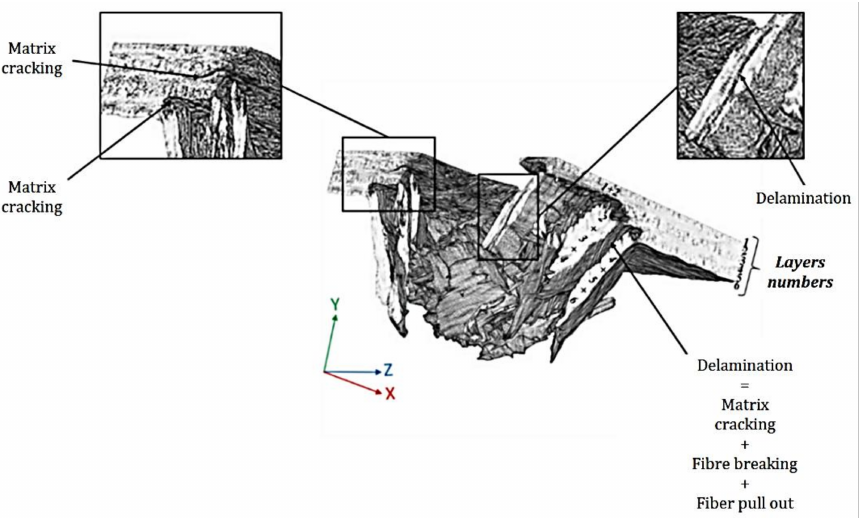
Figure 5. Micro CT scan image of a flax composite specimen (3/4 of the impact hole) after an impact test, with a 50 J impact energy, showing different failure modes in the specimen reproduced from [169] MDPI, 2020.